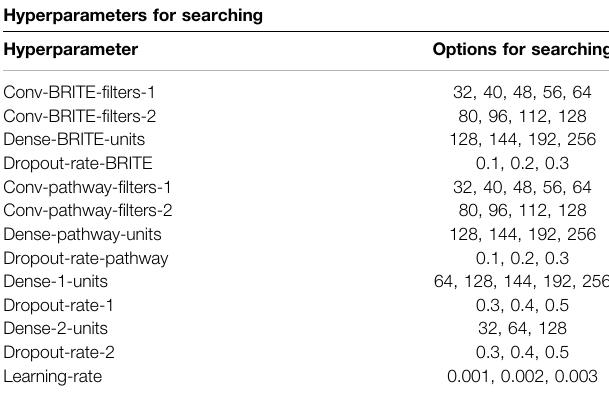
TABLE 2 | The hyperparameter searching space of the DL models for searching with Bayesian optimization. Hyperparameters for